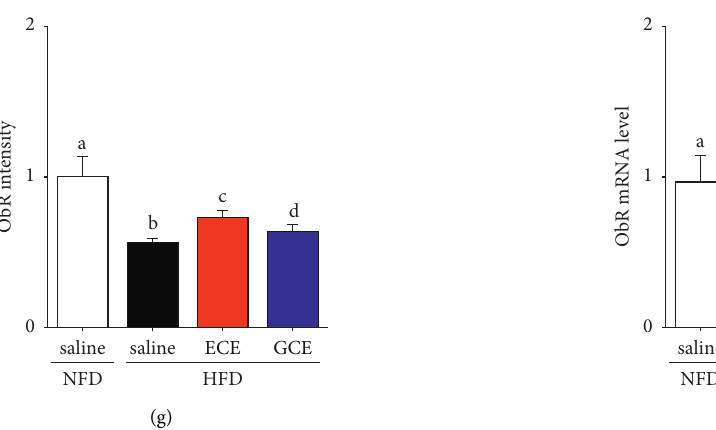
Figure 5: Effects of E . cava extract on serum leptin and adiponectin levels and on leptin resistance in visceral fat of high-fat diet- (HFD-) induced obese mice. (a, b) Serum leptin and adiponectin levels were quantified by ELISA in standard normal fat diet with 0.9% saline (NFD/ saline; open bar), HFD with 0.9% saline (HFD/saline; black bar), HFD with E . cava extract (HFD/ECE; red bar), and HFD with Garcinia cambogia extract (HFD/GCE; blue bar) groups. The suppressor of cytokine signaling 3 (SOCS3) as leptin resistance-related molecule protein level (c) (green), (d) quantified intensity graph, and the (e) SOCS3 mRNA expression level was validated by immunostaining and qRT-PCR. Like SOCS3, ObR receptor protein level ((f) green), (g) quantified graph, and (h) the ObR mRNA expression level were validated by immunostaining and qRT-PCR in visceral fat. Nuclei were detected by DAPI (blue) in confocal microscopic images. All mRNA levels expressed relative mRNA level and normalized ß-actin of the NFD/saline group. Scale bar � 50 μ m. The same letters represent no significant difference ( p < 0 .